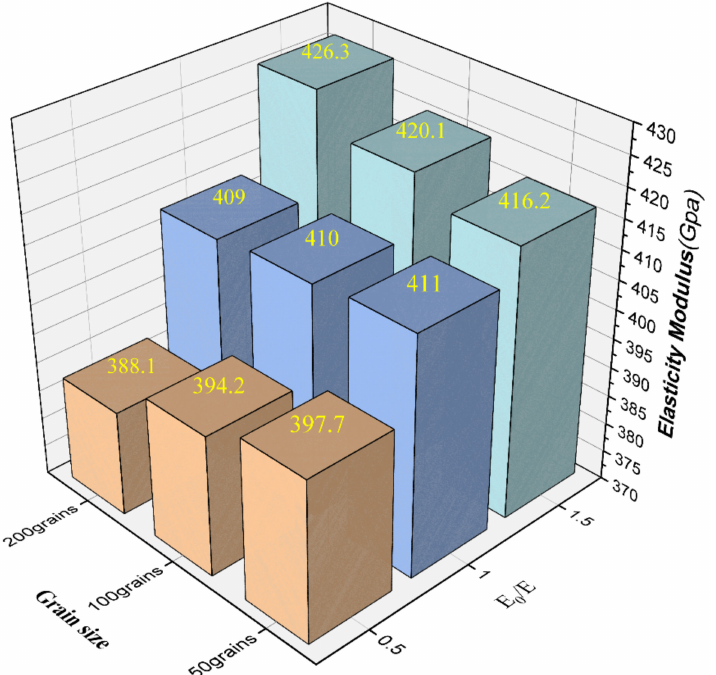
Figure 15. Effective elastic modulus at different grain sizes for three different grain boundary elastic